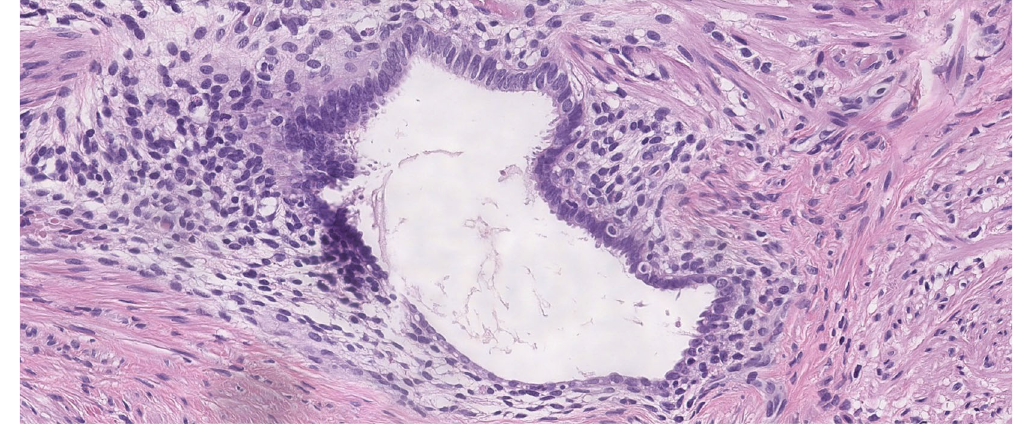
Figure 4: Magni fi cation 200 ×